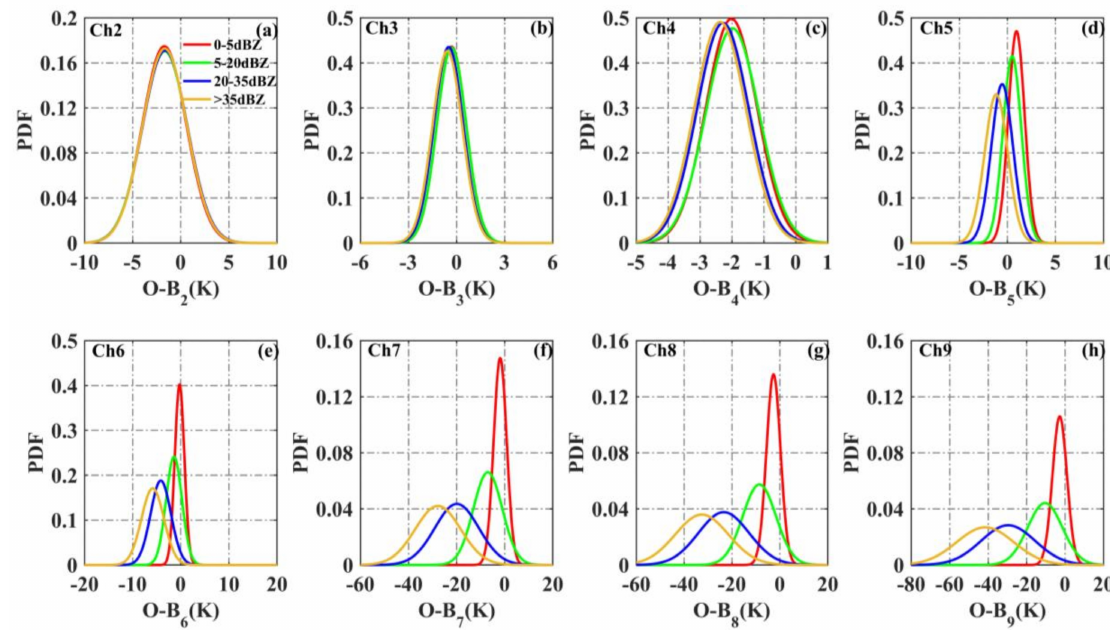
Figure 12. The same as Figure 11, but for channels 2–9 ( a–h